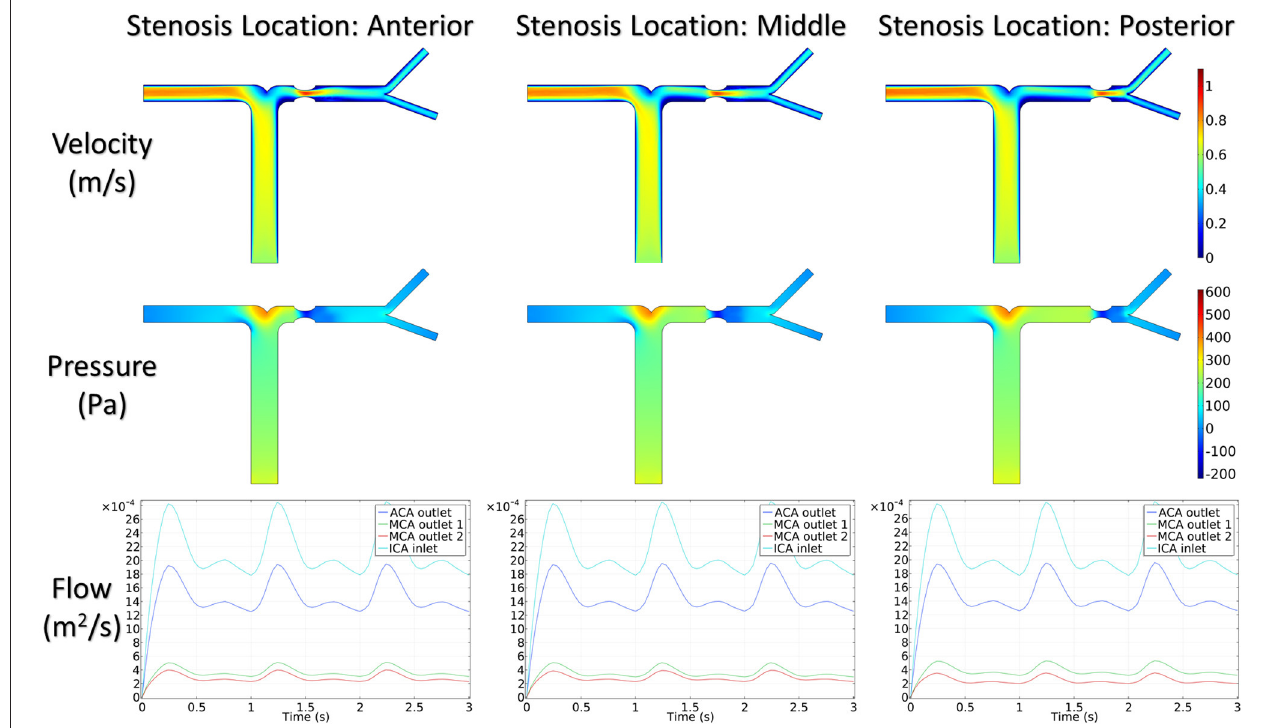
FIGURE 6 | Velocity, pressure, and inlet/outlet flow alternation with the location of stenosis.